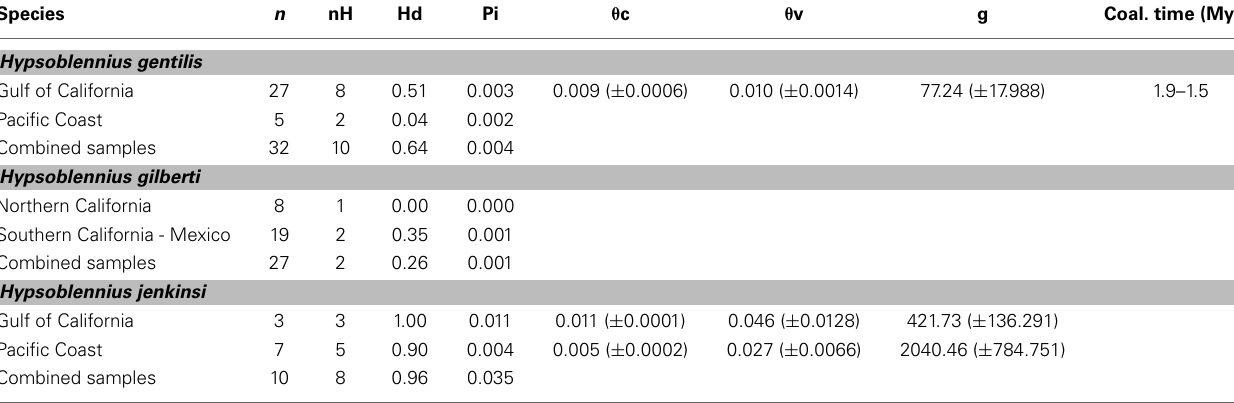
Table 2 | Demographic parameters for Hypsoblennius gentilis, H. gilberti, and H. jenkinsi based on the mitochondrial control region.